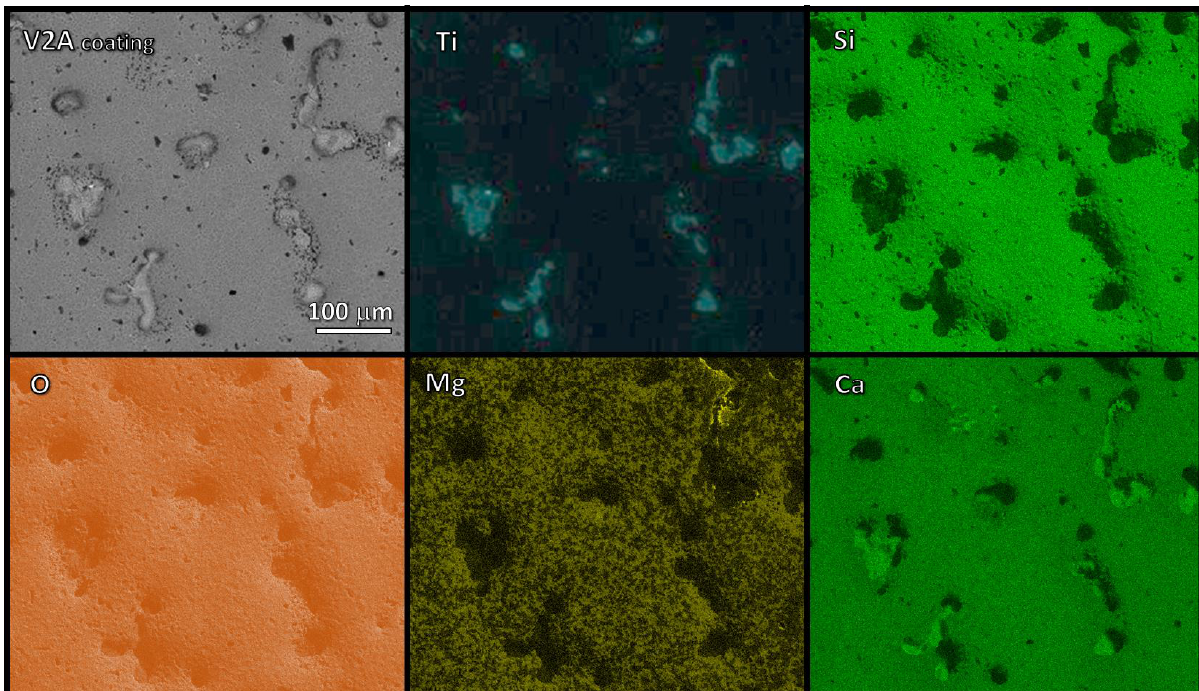
Figure 6. EDS maps of V2A (1.5 s) glass – ceramic coating. A clear separation of the elements between coated and uncoated zones was charac- teristic for the glass – ceramic coatings fired in argon, irrespective of the amount of silicone (less silicone in V1N, Figure 7a; more silicone in V2N, Figure 7b). Uncoated zones con- tained titanium. Coated zones contained all other elements (Si, Mg, Ca, and O). The maps of Ca and Si were nearly identical.